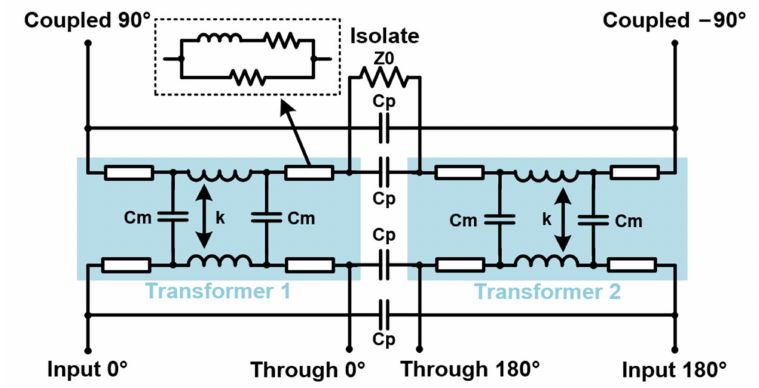
Figure 4. Equivalent model of a fully differential transformer-based quadrature